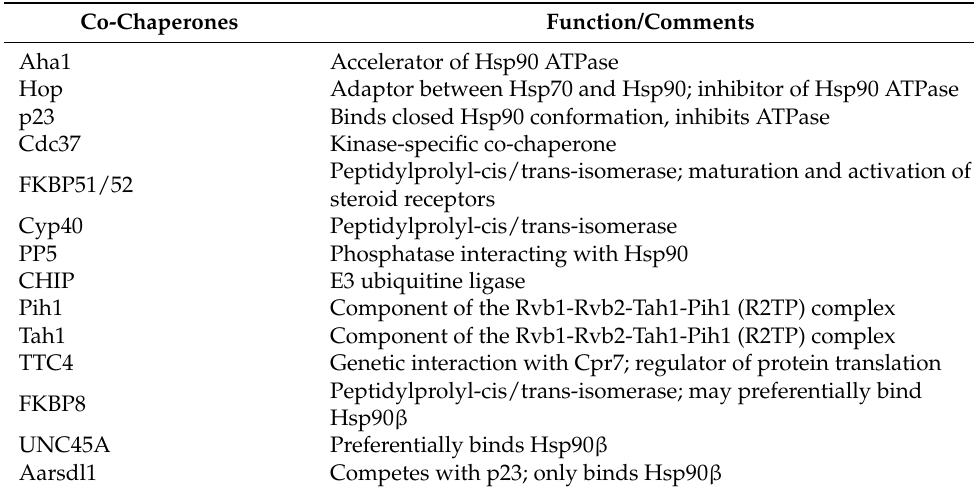
Table 1. Some co-chaperones of Hsp90 α and Hsp90 β 1